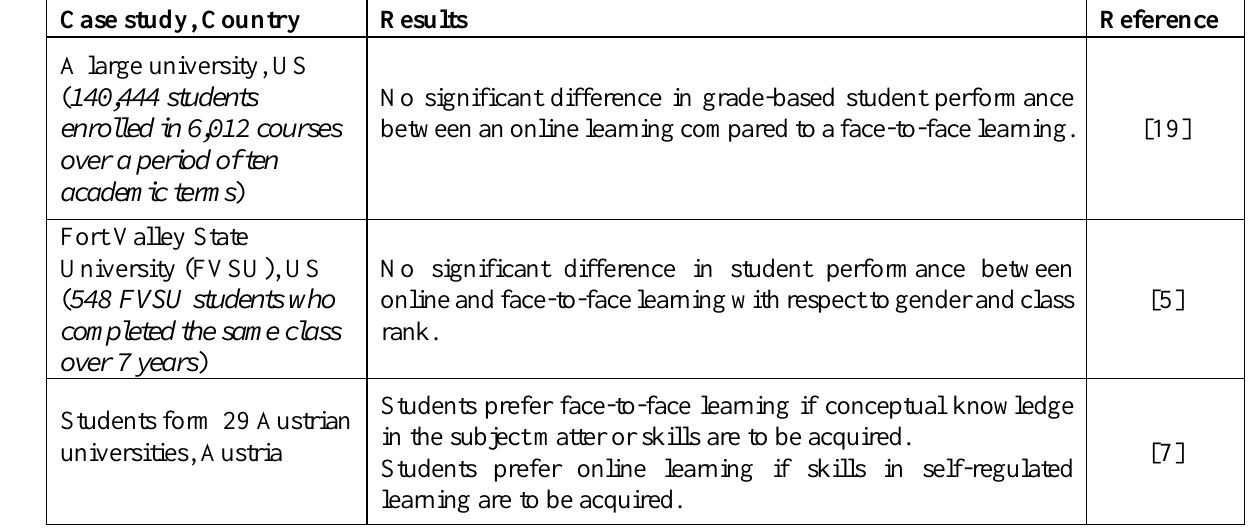
Table 1. Key result comparisons with similar